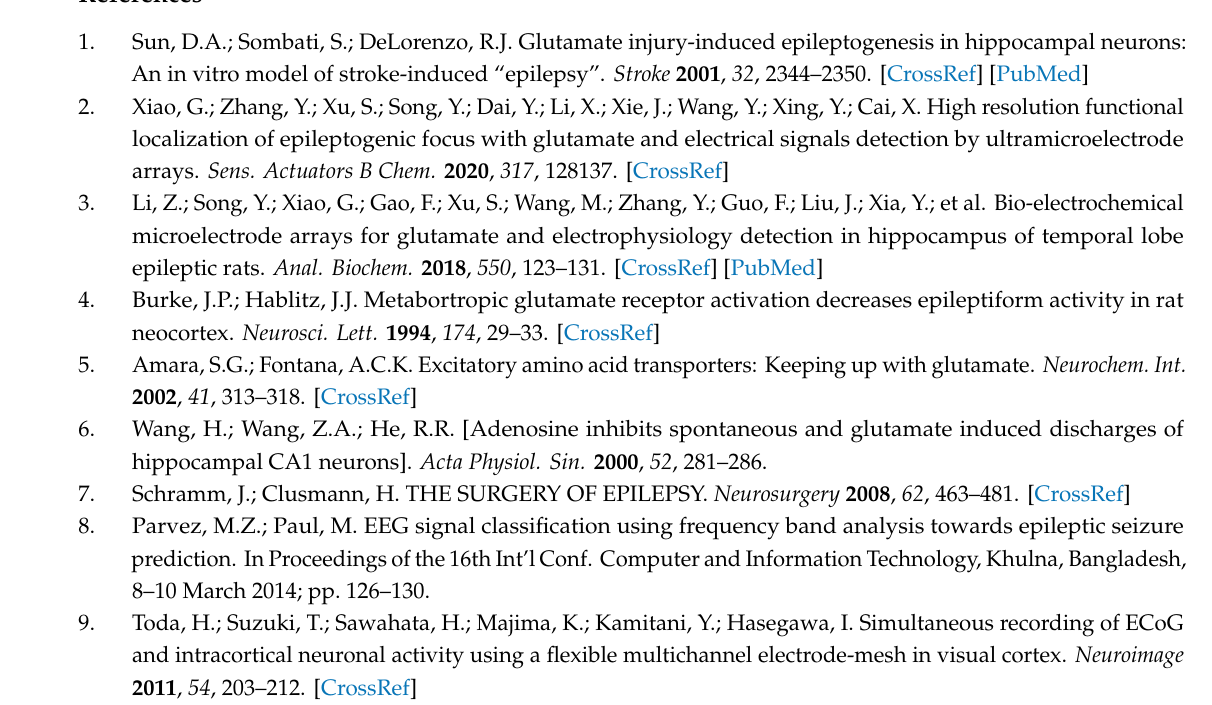
Figure S1: The power of LFPs in multiple frequency bands (Delta (1–4 Hz), Theta (4–8 Hz), Alpha (8–13 Hz), and Beta (13–30 Hz)) at normal and epileptiform states. The data was from Figure 6. The power from three channels were calculated. The power in delta frequency band, theta frequency band, alpha frequency band and beta frequency band increased from 1.50 µ W, 0.62 µ W and 0.44 µ W, 0.35 µ W to 292.47 µ W, 116.37 µ W, 107.45 µ W and 126.86 µ W, respectively. Figure S2: The power of LFPs in multiple frequency bands (Delta (1–4 Hz), Theta (4–8 Hz), Alpha (8–13 Hz), and Beta (13–30 Hz)) at normal and epileptiform states. The power from six channels were calculated. The power in delta frequency band, theta frequency band, alpha frequency band and beta frequency band increased from 0.65 µ W, 0.50 µ W and 0.44 µ W, 0.38 µ W to 353.27 µ W, 101.36 µ W, 72.39 µ W and 36.98 µ W,